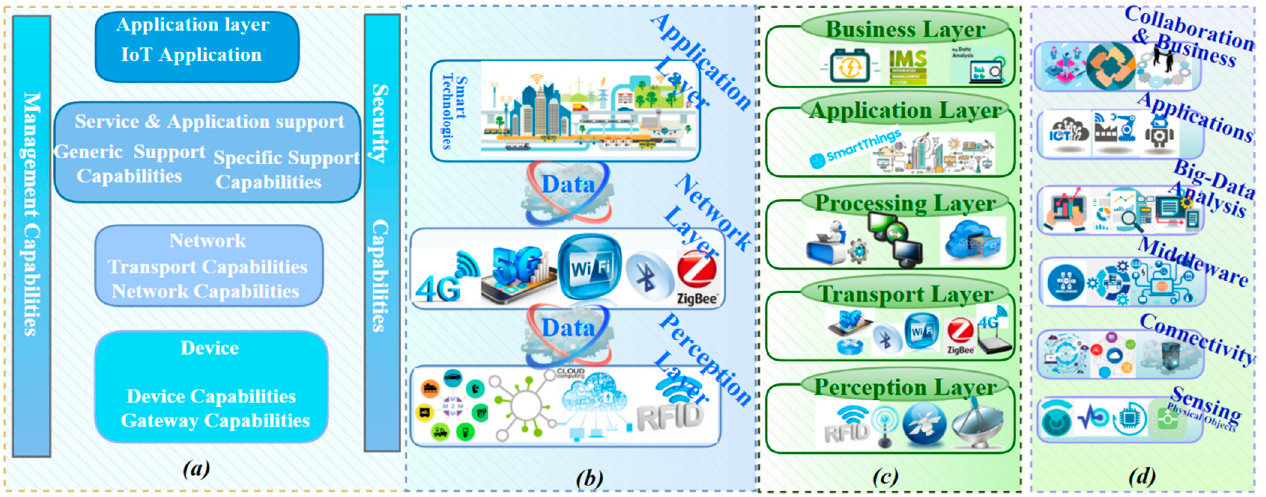
Figure 3. Comparison and layers mapping of ( a ) ITU-T functional architecture view [54]; ( b ) three-layer IoT architecture; ( c ) five-layer IoT architecture; ( d ) six-layer IoT architecture.